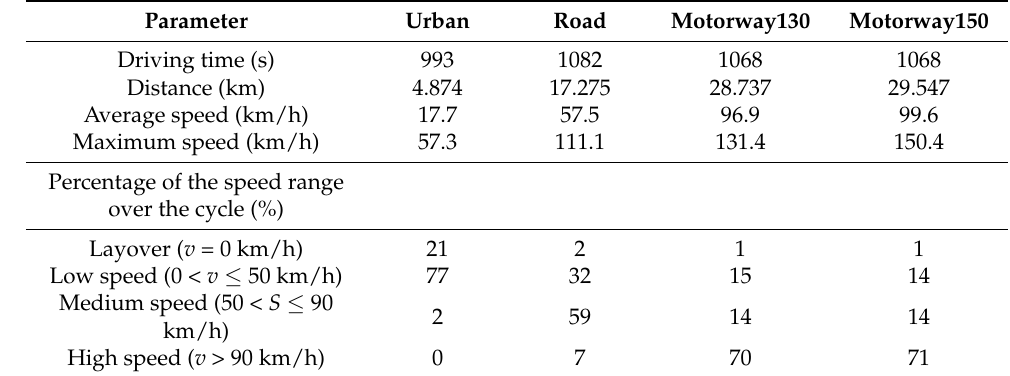
Table 2. Artemis driving cycle parameters.